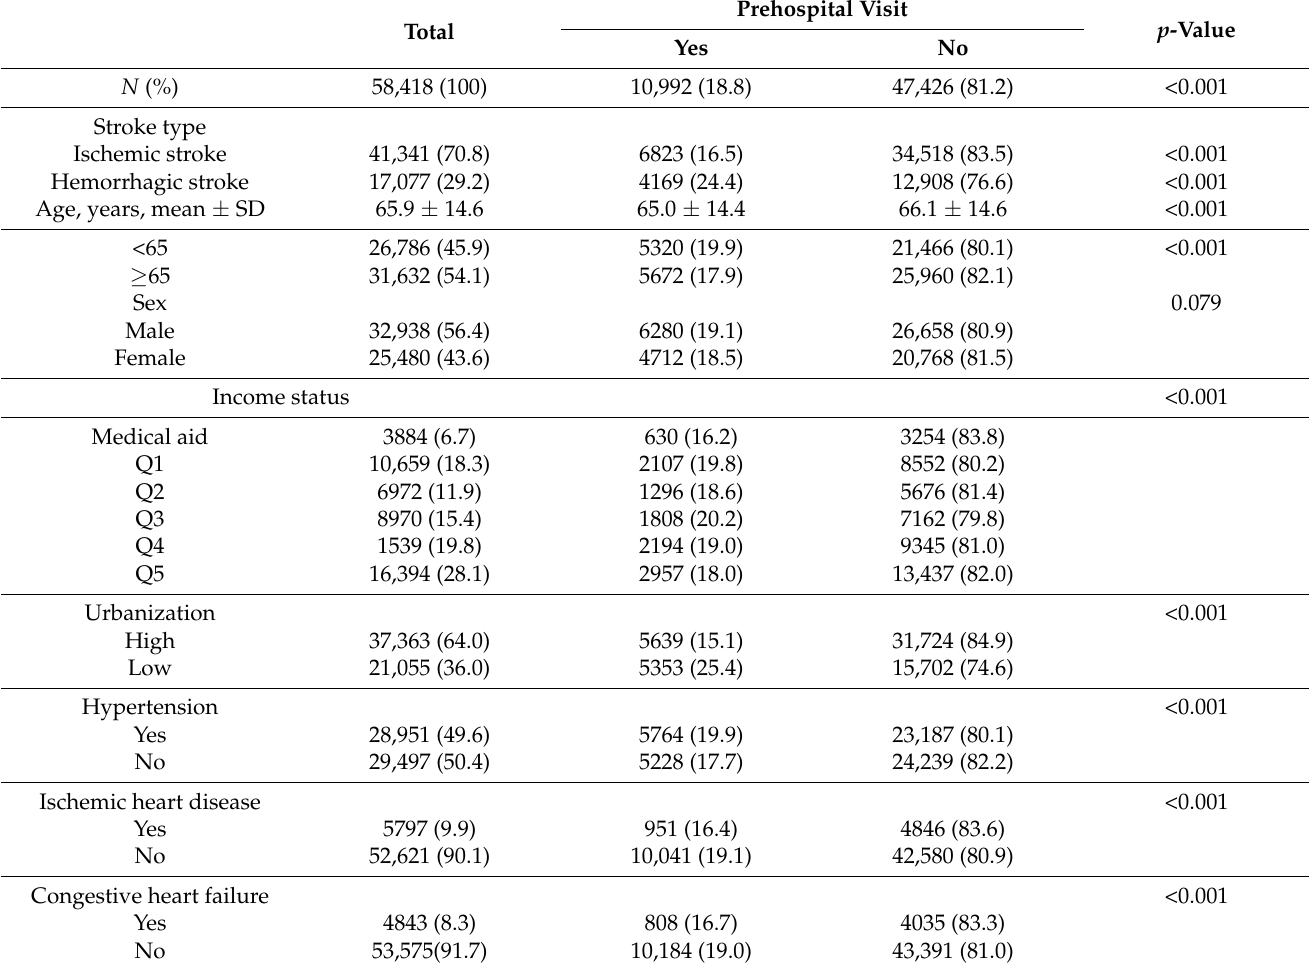
Prehospital Visit